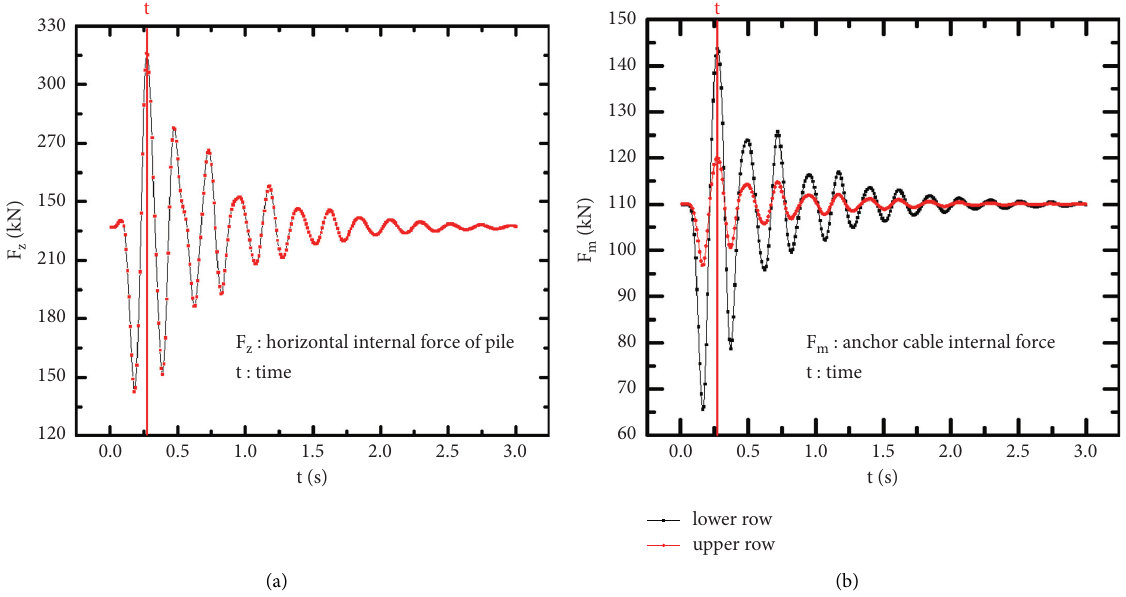
Figure 10: Internal force response curve of pile anchor composite structure.